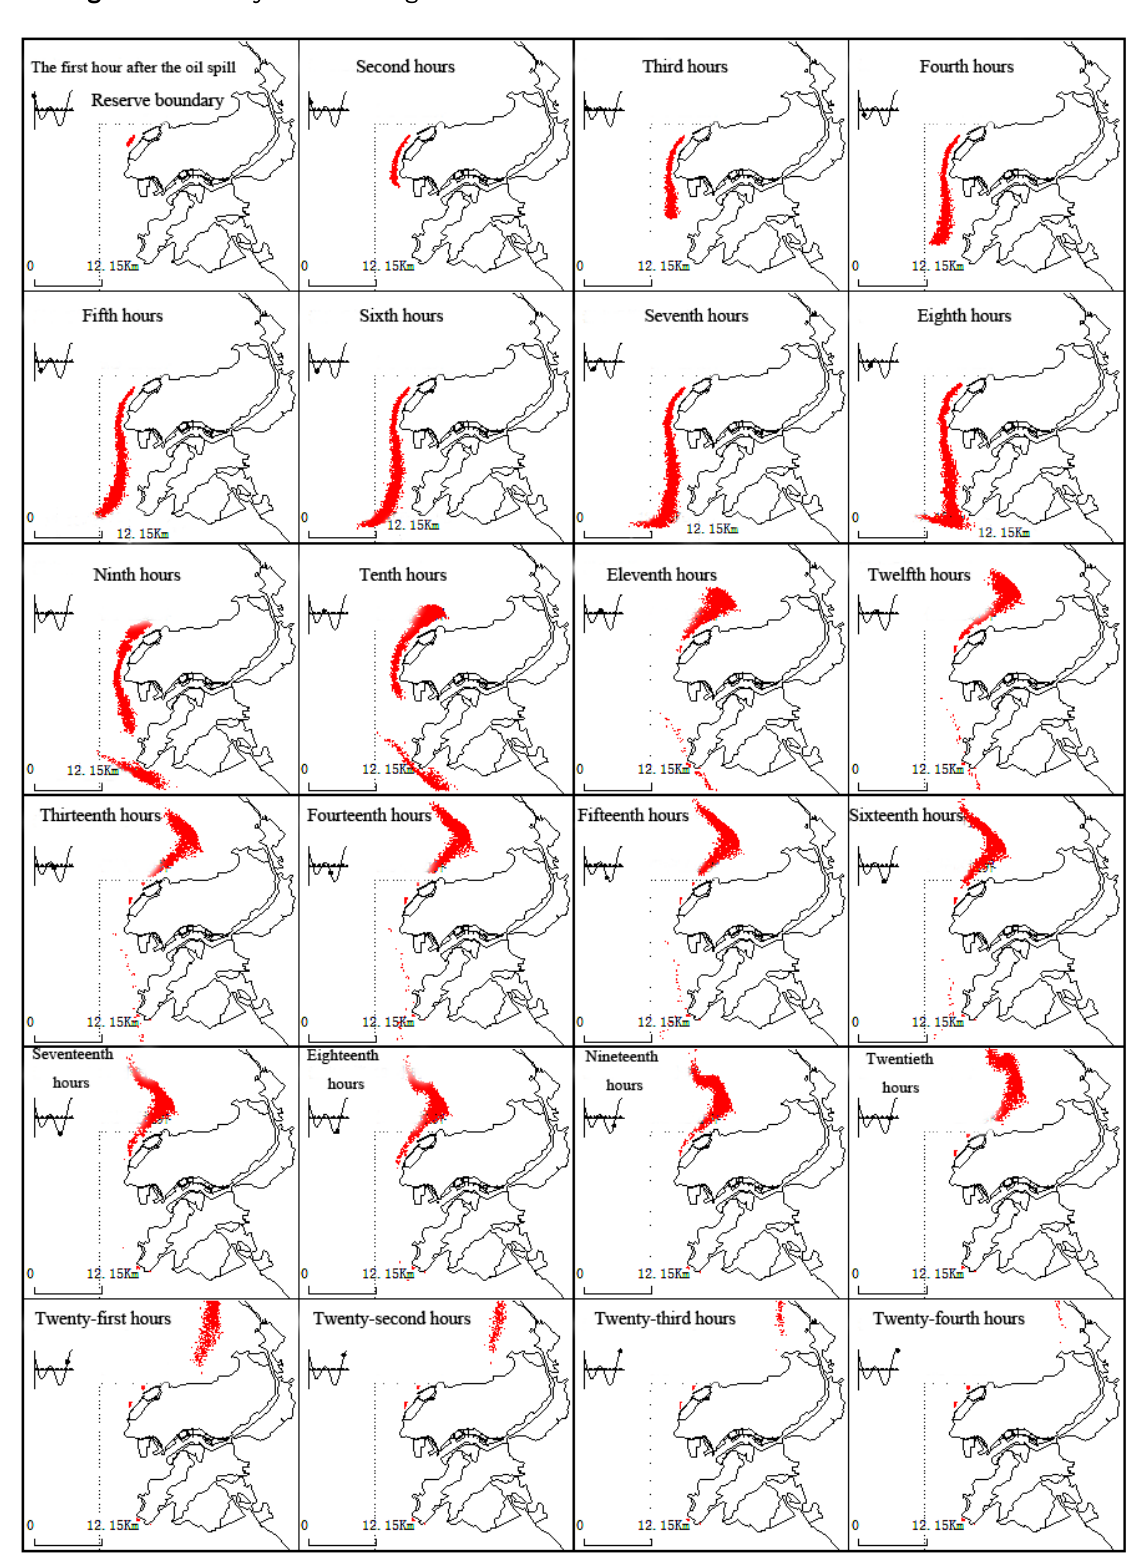
into the Fuzhou Bay. After the sixteenth hour, the oil film lands on the beaches of Xian Yu Bay. Figure 1. The dynamic changes of the oil film under continuous drift tide